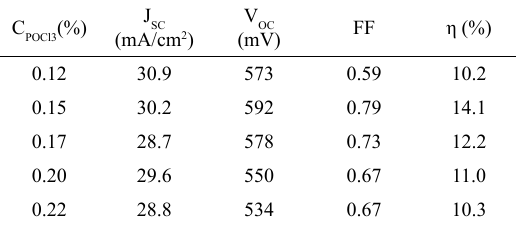
Figure 2. Electric current density as a function of the applied voltage of the solar cells with the highest efficiency, processed with POCl concentration of 0.12%, 0.15%, 0.17%, 0.20% and 3 0.22% and aluminum and phosphorus diffusion performed in the same thermal step. Table 2. Short-circuit current density, open circuit voltage, fill factor and efficiency of the solar cells with the highest efficiency concentration. as a function of POCl 3